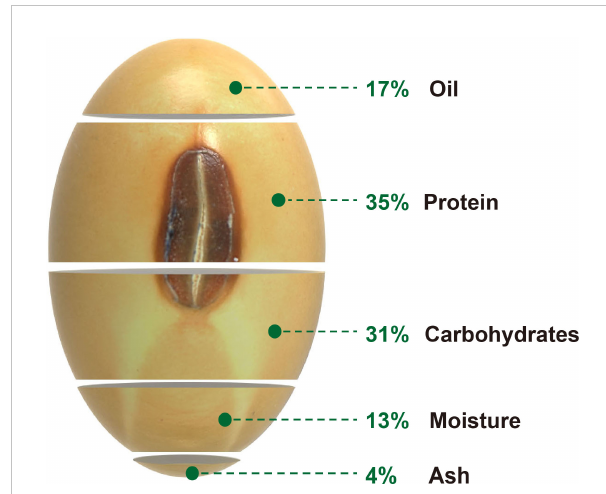
FIGURE 1 Composition of stored mature soybean seeds. The percentage value indicates the relative weight of the corresponding component in a seed (Liu,